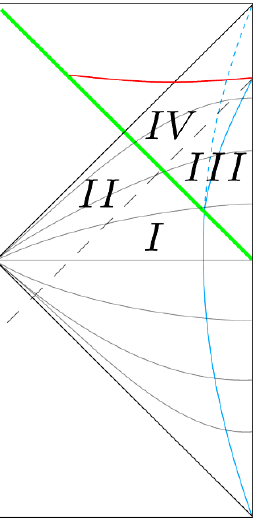
Figure 13 . AdS 2 Vaidya geoemtry. The shockwave (green) is inserted from the boundary and falls to form a black hole horizon (dashed) and singularity (red). The original AdS 2 Poincare slicing (grey) covers the entire spacetime. This same diagram applies of a shockwave falling into a black hole where now the Poincare horizon can be thought of as its horizon. The Roman numerals label the regions de(cid:12)ned